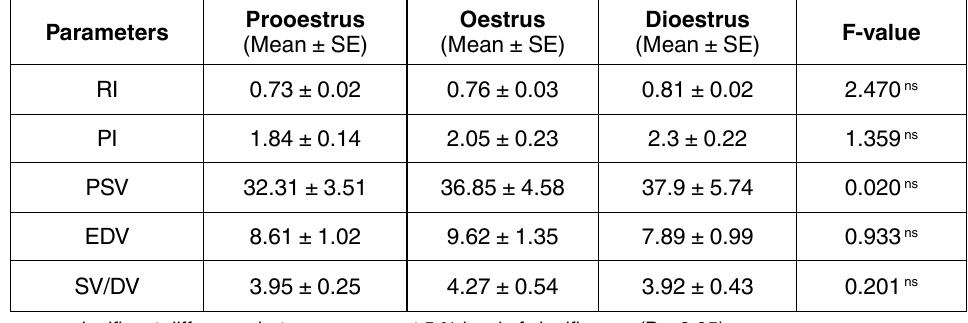
table 1. Pulsatility index (PI), Resisitivity index (RI), systolic/diastolic ratio (S/D), Peak Systolic Velocity (PSV) and End Diastolic Velocity (EDV) of ventral perineal artery during